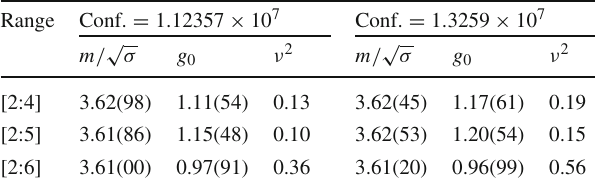
Table 1 Fits of the glueball correlation function with the reduced chi squared being ν 2 = χ 2 / d . o . f . Range Conf. = 1 . 12357 × 10 7 Conf. = 1 . 3259 × 10